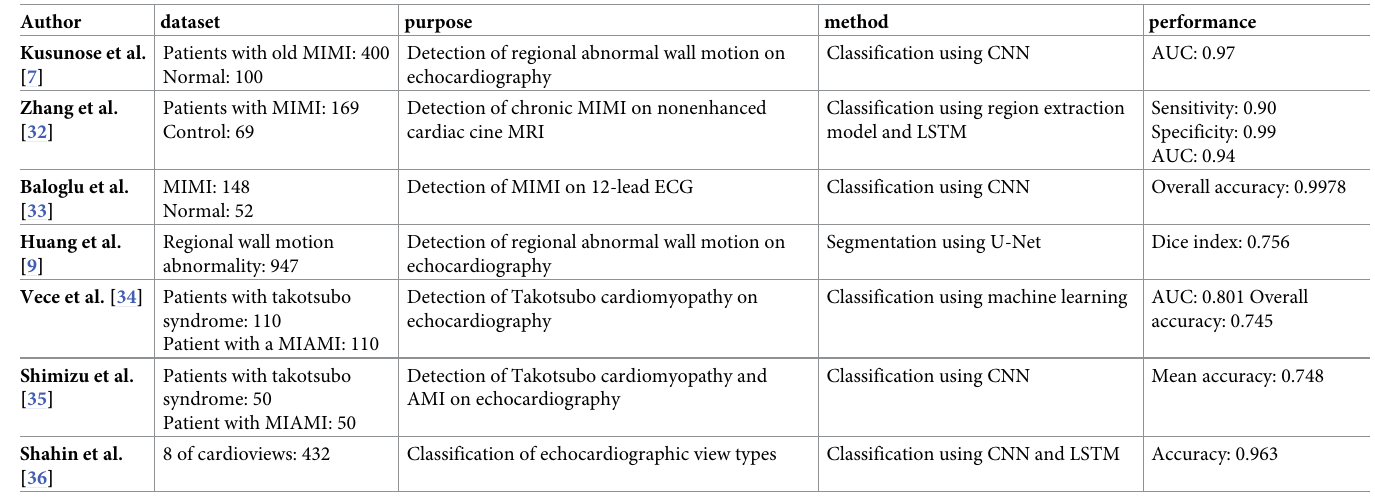
Table 9. Comparison of related